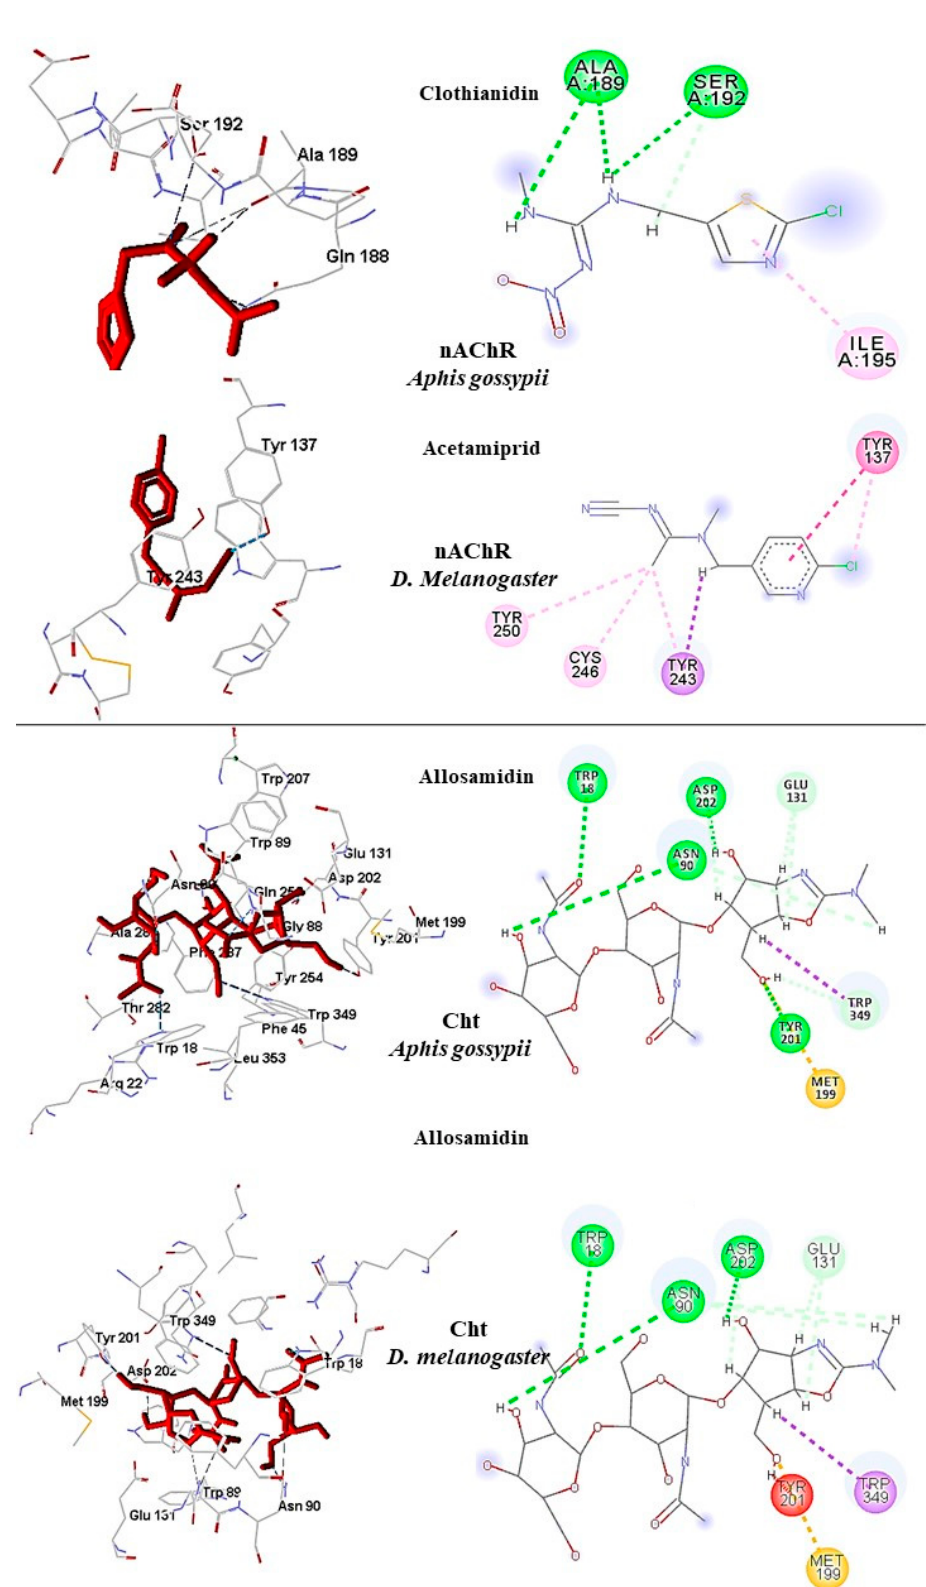
Figure 11. Interactions (3D and 2D) between clothianidin and A. gossypii -nAChR; Acetamiprid and D. melanogaster -AchE; Allosamidin and A. gossypii -Cht; and Allosamidin and D. melanogaster -Cht. Hydrogen bonds are highlighted in green, hydrophobic interactions are highlighted in pink, and steric interactions are highlighted in red.